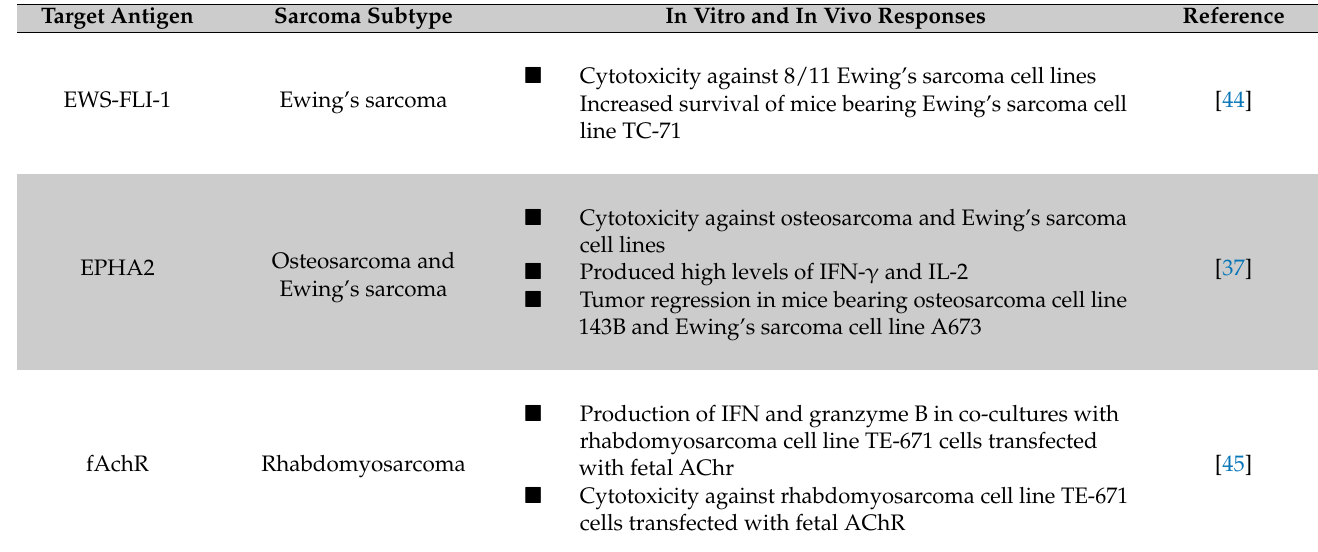
Table 2. New CAR T cell targets for pediatric sarcoma currently under development in pre-clinical models. Target Antigen Sarcoma